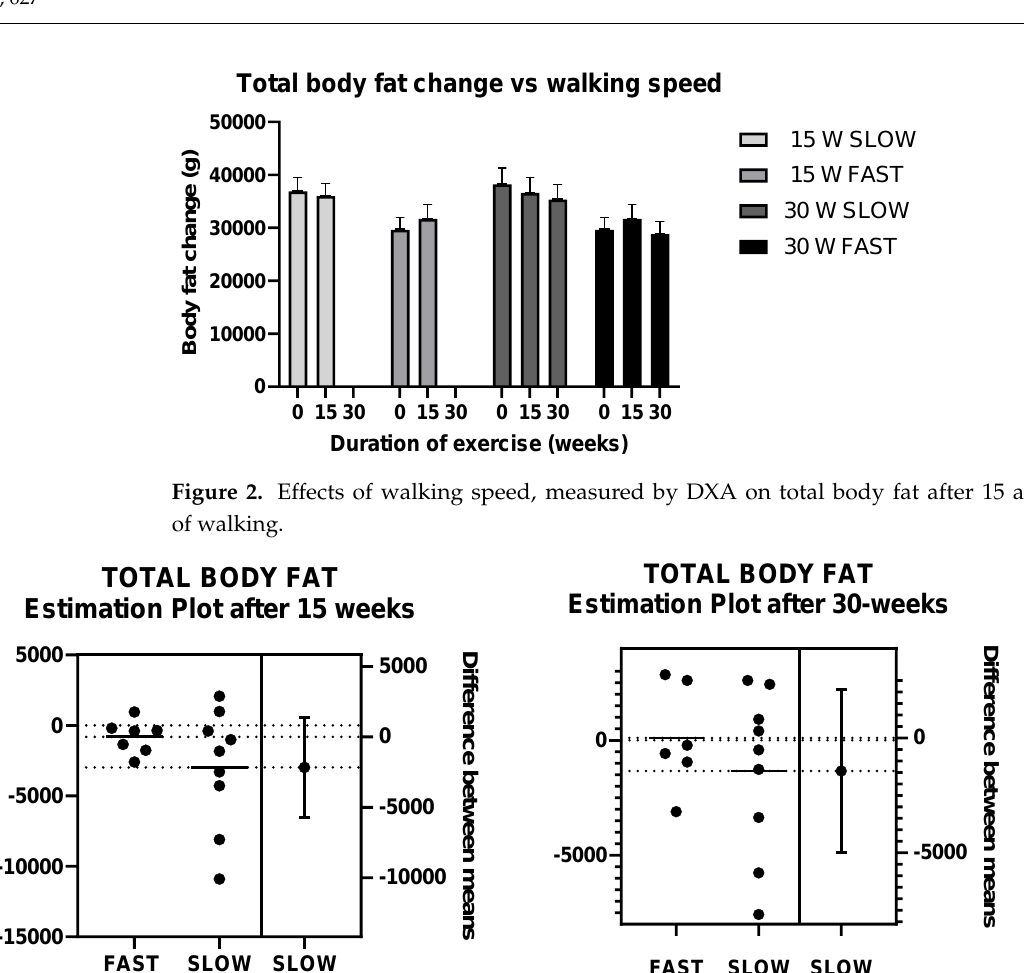
Figure 4. Skinfold and circumference percent changes in 15-week and 30-week groups. Upper arm Circs reflected changes in SC fat, while changes in the calf Circ likely reflected changes in LBM as the calves were engaged in walking. In the 15-week group, upper arm Circ did not change in slow walkers and decreased by 0.9% in the fast walkers. In the 30-week group after 15 and 30 weeks of walking, upper arm Circ decreased by 1% and 0.9% by week 30 . Calf Circ, on the other hand, increased in the 15-week group at both the slow (1.4%) and fast (2.5%) speeds. Corresponding increases in calf Circ in the 30-week